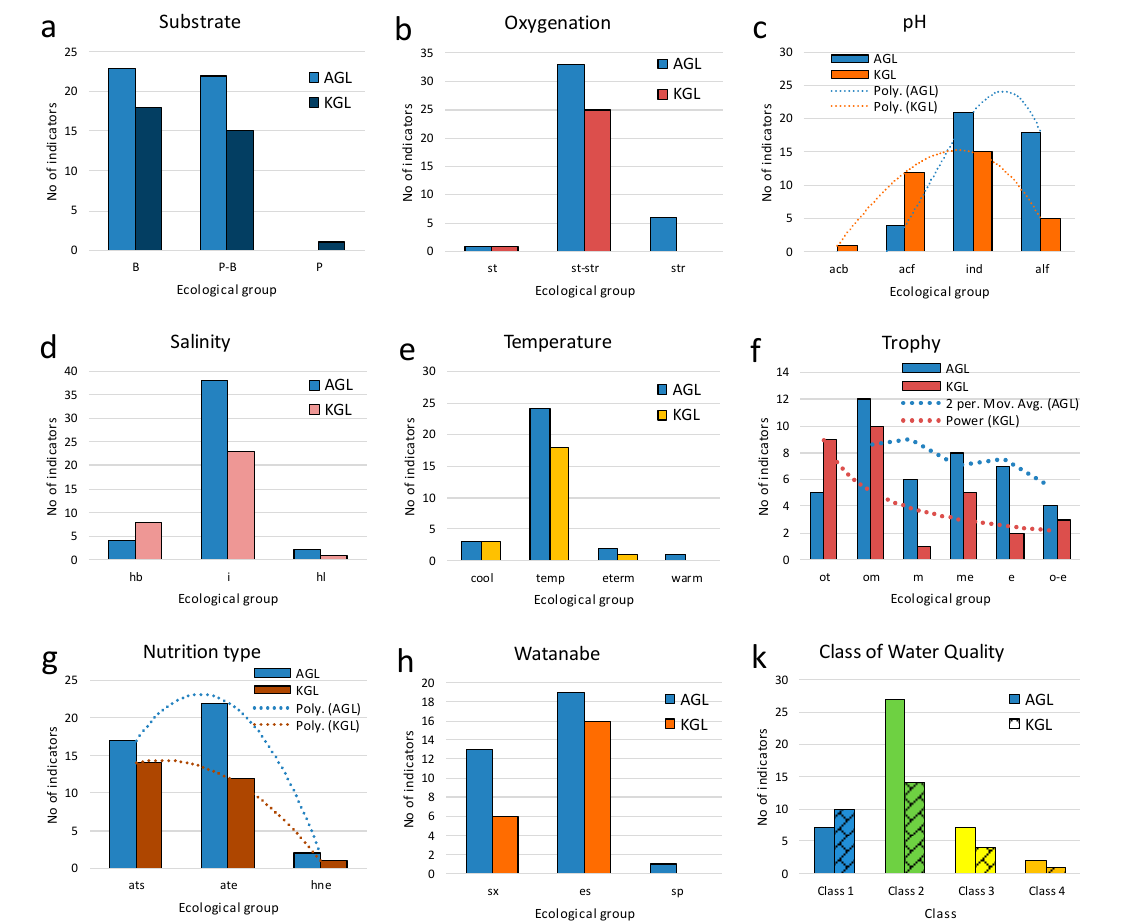
Figure 6. Distribution of indicator species number over the ecological groups in the Avusor Great Lake (AGL) and Koçdüzü Great Lake (KGL). Abbreviations: Substrate ( a ) B, benthic; P-B, planktonic–benthic; P, planktonic. Oxygenation ( b ) str, streaming well oxygenated waters inhabitant; st-str, low streaming medium oxygenated waters inhabitant; st, standing low oxygenated water inhabitant. Water pH ( c ) acf, acidophilic species; ind, indifferent; alf, alkaliphilic species; acb, acidobiontes. Water salinity ( d ) hb, halophobe; i, oligohalobious-indifferent; hl, oligohalobious-halophilous). Water temperature ( e ) cool, cool-loving species; temp, temperate temperature water inhabitants; eterm, eurythermic species, warm, warm water inhabitants. Trophic state ( f ) ot, oligotrafentic; o-m, oligo-